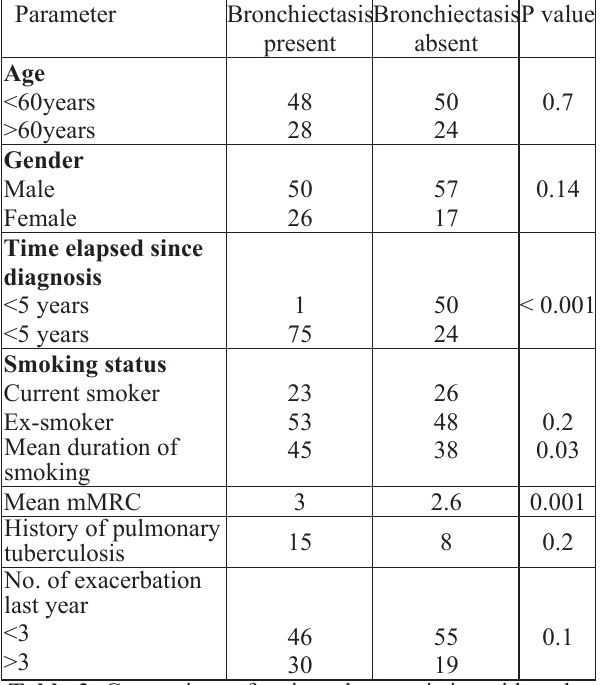
Table-3: Comparison of patient characteristics with and without